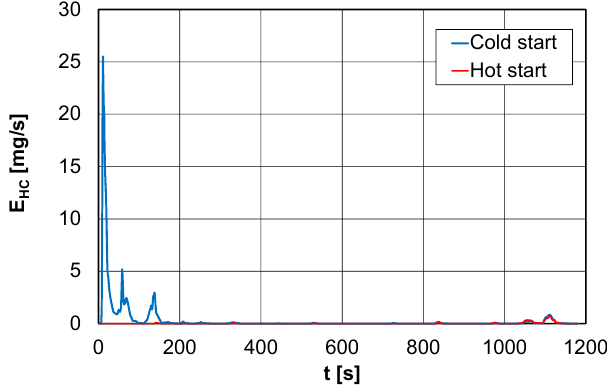
Figure 4. Hydrocarbon exhaust emissions (E HC ) for cold and hot engine start.